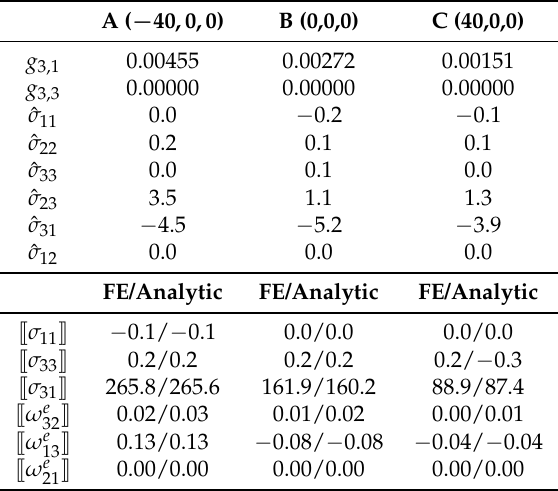
Table 6. Values of ˆ σ (MPa) and ∇ g provided by the FE simulation 6 and used to compute the analytic ∼ formulas (28)–(30) and (32) (top). Comparisons of the values of [[ σ simulation 6 and those computed from the analytic formulas